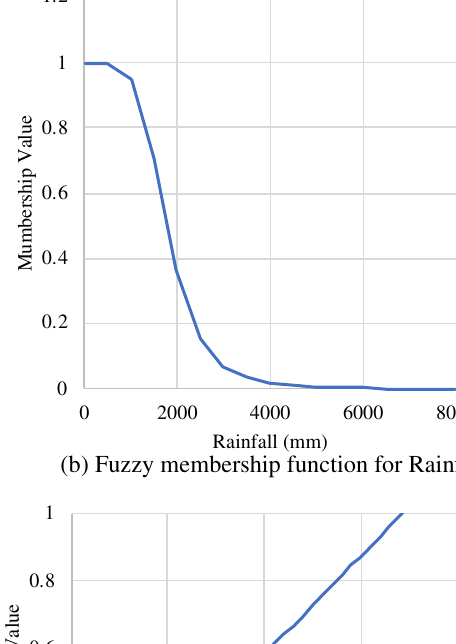
(b) Fuzzy membership function for Rainfall(a) Fuzzy membership function for NDWI